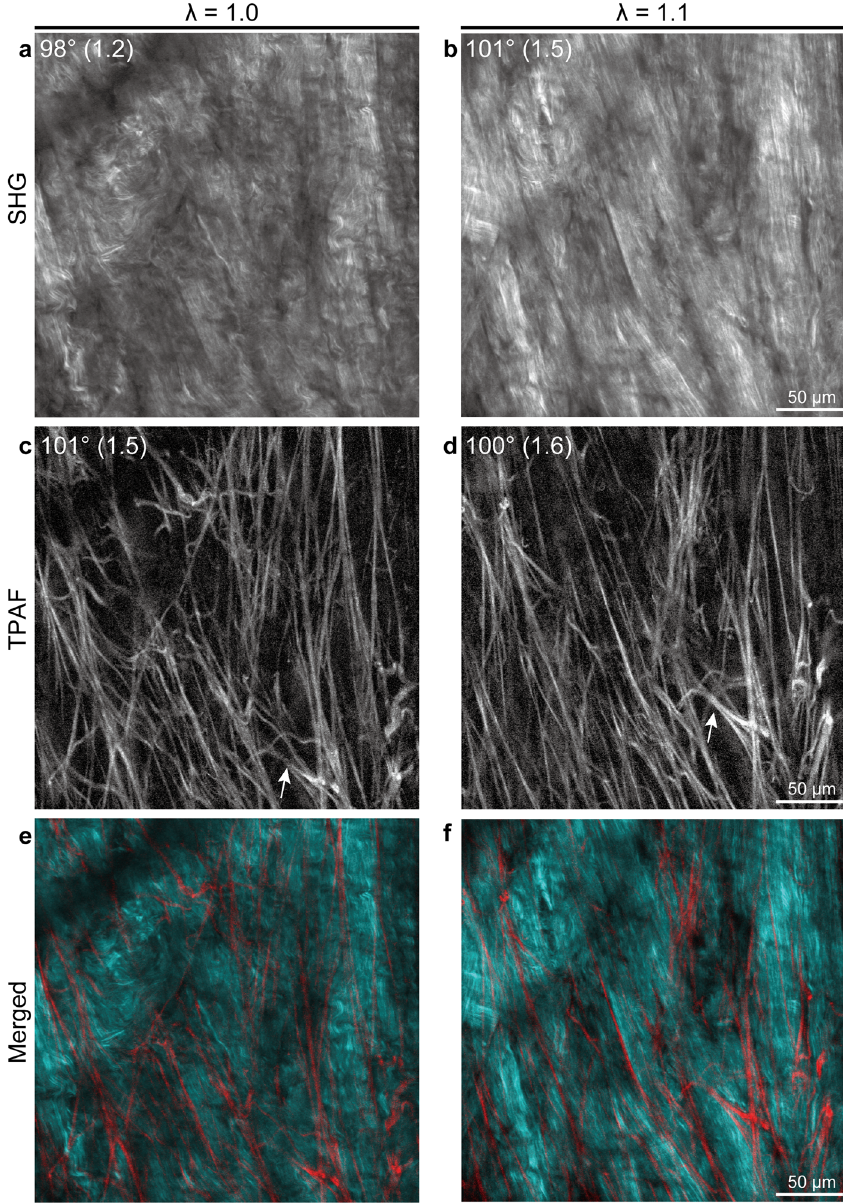
Figure 6. Dynamic multiphoton microscopy images of joint ligament architecture under biaxial tissue extension. Second harmonic generation (SHG) images show architectural changes in collagen fibers ( a , b ) whereas two-photon autofluorescence (TPAF) images show architectural changes in elastic fibers ( c , d ). λ represents the stretch ratio. Arrows of the same shape indicate the same elastic fiber. The orientation and degree of orientation (parentheses) are shown for each SHG and TPAF image. Note that regularly aligned collagen fibers became more identifiable because they became less wavy, resulting in an increased degree of orientation on